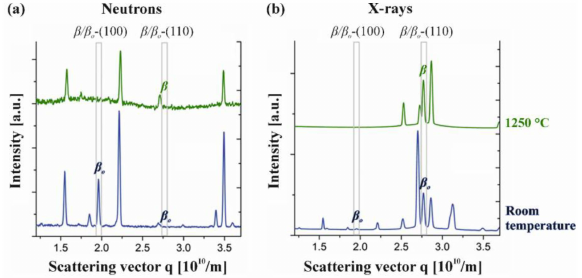
Figure 3. Diffraction patterns of a TNM alloy obtained by ( a ) neutron and ( b ) X-ray diffraction at elevated temperatures (top), as well as at room temperature (bottom) [62]. Differences between the patterns of the ordered β o phase at room temperature and of its disordered form β at 1250 ˝ C are exemplarily accentuated. In the case of neutron scattering, the β -(100) superstructure peak appears strong, whereas the fundamental β -(110) peak is hardly discernible from the background. In the case of X-rays, the fundamental peak exhibits a high intensity, while the superstructure peak at room temperature shows only a small